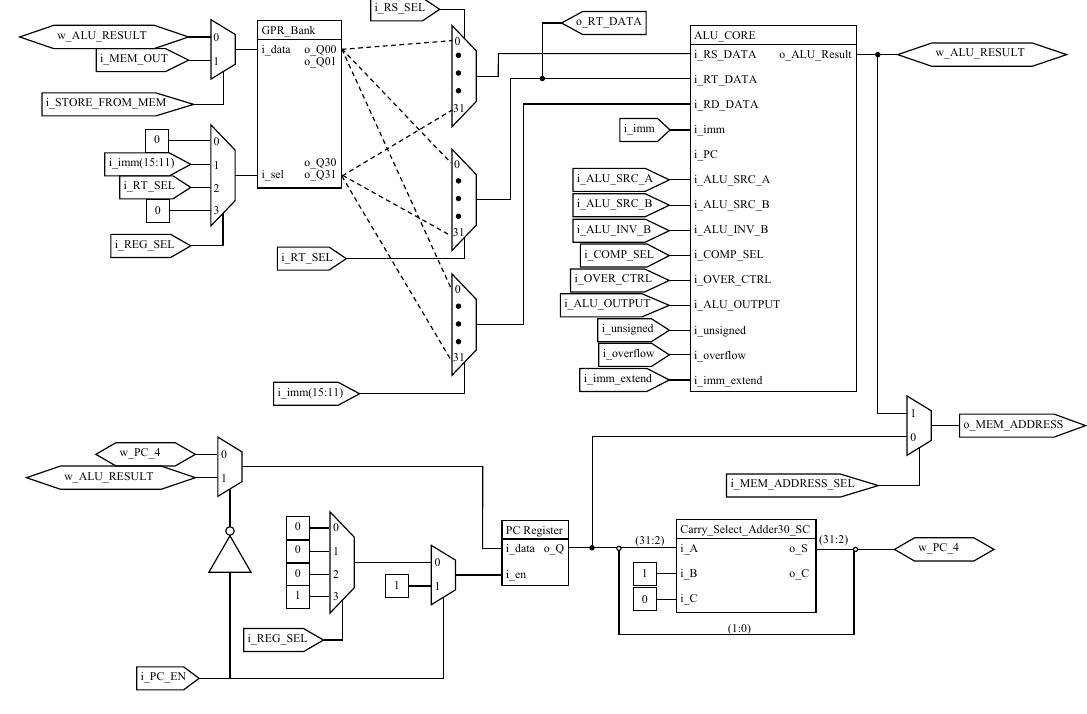
Figure A1. Basic MIPS Datapath Schematic.